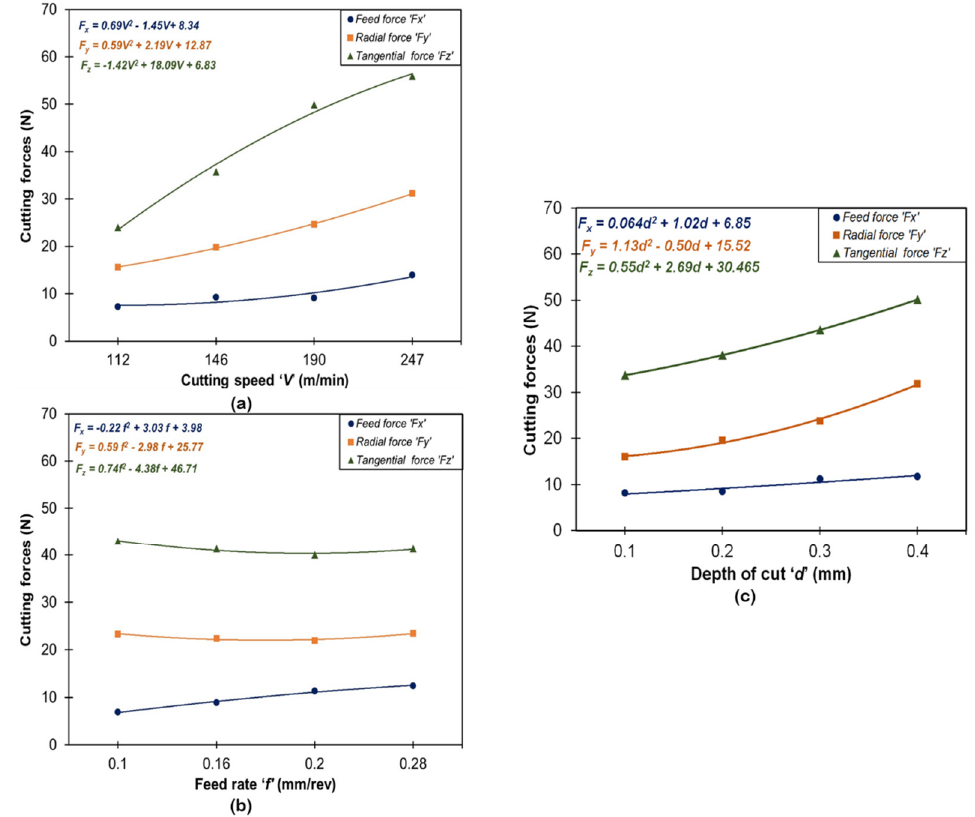
Figure 5. Variation in cutting forces under the influence of: ( a ) speed; ( b ) feed; ( c ) depth of cut.